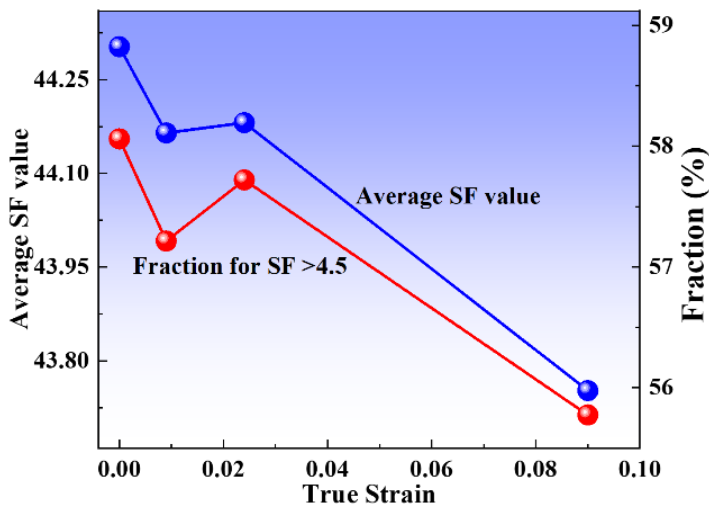
Figure 11. The evolution of the Schmid Factor (SF) values at various true strains.